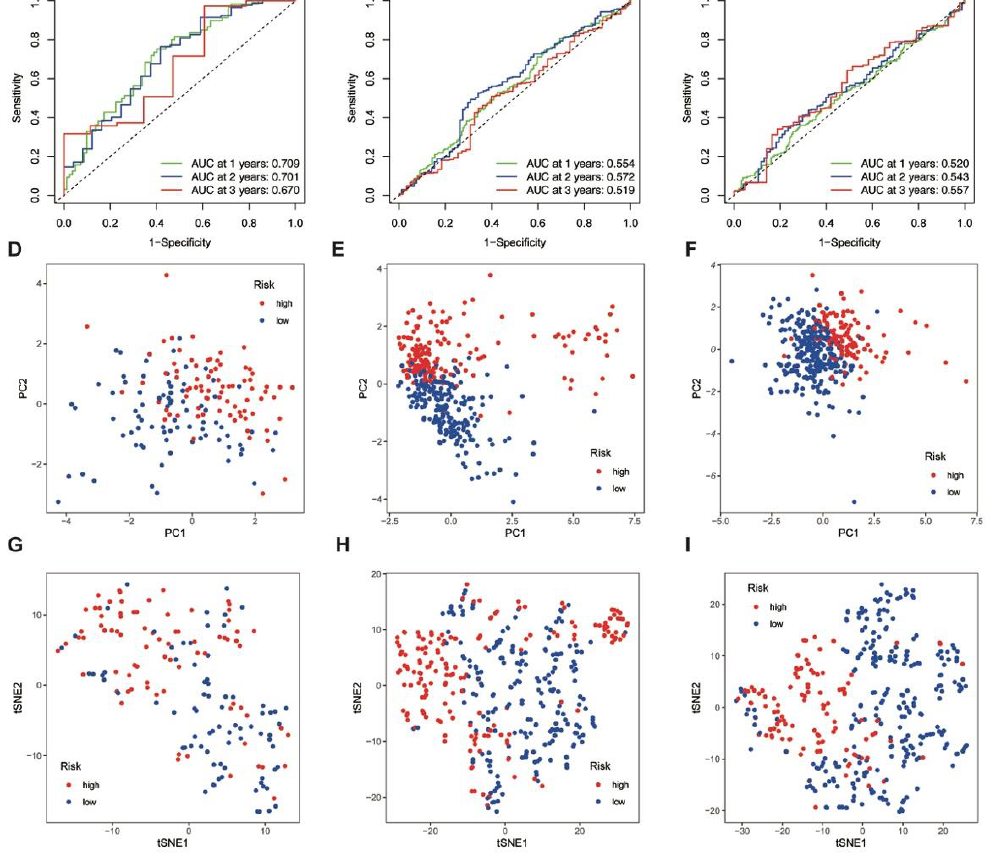
Figure 3. ROC analysis, PCA, and t-SNE analysis for risk score classification in GBM patients. (A – C) ROC analyses of risk scores for 1-, 2- and 3-year survival of GBM patients were conducted in TCGA ( A ), CGGA ( B ), and GEO ( C ). ( D – F ) The PCA supported the classification of GBM